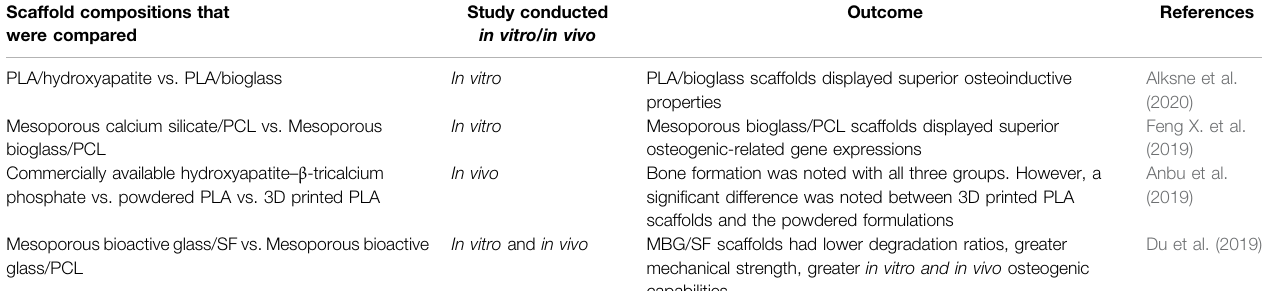
TABLE 2 | A summary of the different studies comparing different scaffold compositions and their bone regeneration outcomes. Scaffold compositions that were compared